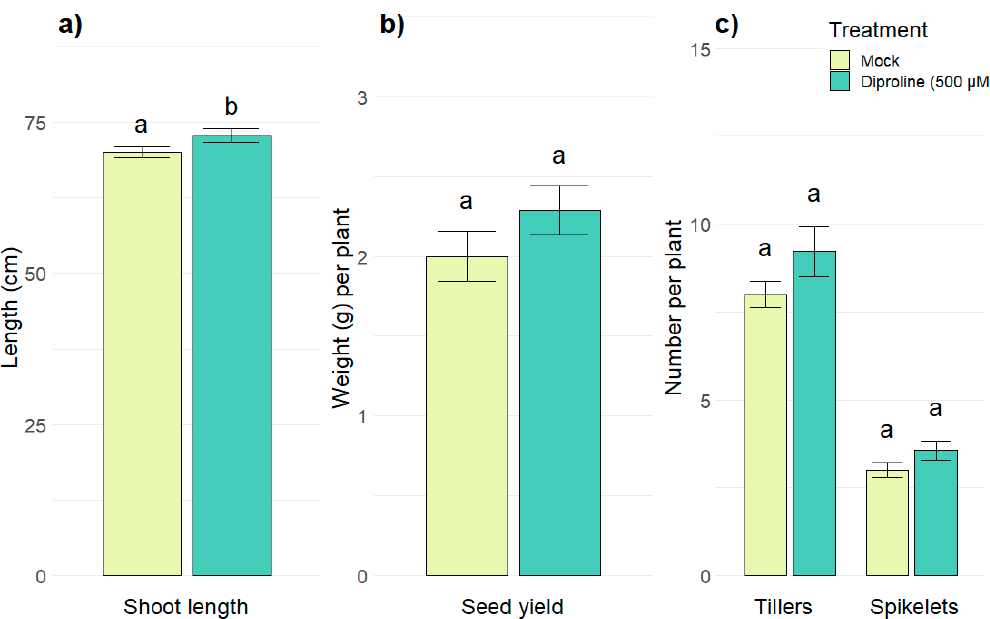
Figure 4. Evaluation of the effects of diproline treatment on plant growth and yield. ( a ) Shoot length, ( b ) seed yield and ( c ) number of tillers and spikelets of four-month-old rice plants after being treated with water or a solution of 500 µM diproline every other week. The bars show the average of 36 plants per treatment, analyzed over two replications. To cancel out batch effects, data from the replicate experiments were combined and normalized. Error bars indicate standard errors. Letters represent statistical differences in comparison with the mock treated plants.